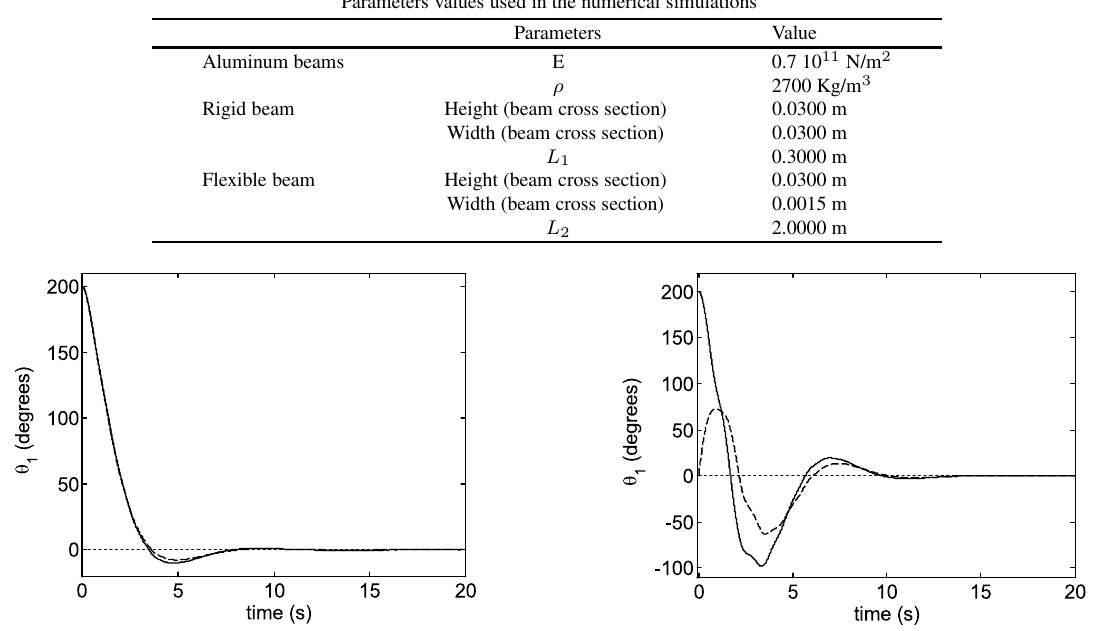
Fig. 4. Estimated (- - -) and “real” (—) behavior of measured vari- able θ 1 considering different initial